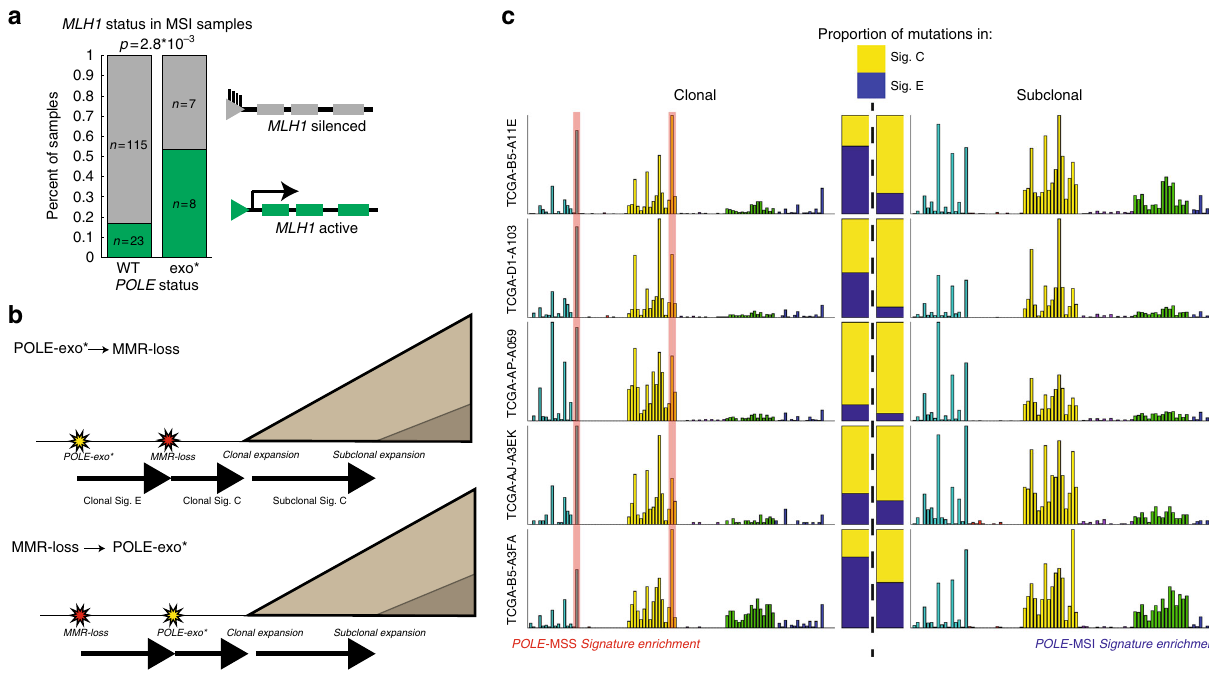
Fig. 6 Timing of POLE -exo* and MSI events. a Frequency of MLH1 silencing as the mechanism of MMR de fi ciency in POLE WT vs. POLE -exo* cases. 153/160 MSI-H samples with MLH1 silencing data available are shown. b Model representing accumulation of clonal and subclonal mutations based on the order of POLE and MSI events. c Mutational spectra of the fi ve cases displaying signi fi cant enrichment of signature E ( POLE -exo*) mutations in the clonal subset of mutations, suggesting that the POLE -exo* event preceded acquisition of MSI in these samples. Stacked bars represent the relative contributions of signatures E and C to the clonal and subclonal spectra of each patient. In each case, signature E (blue) is enriched in the clonal